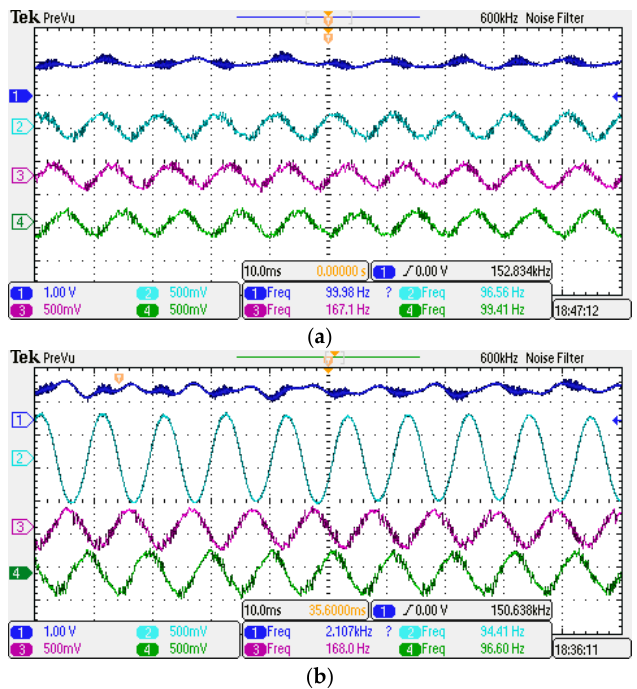
Figure 10. Measured torque (trace 1) and currents (traces 2–4). (10 ms/div, 2 Nm/div, 5 A/div): ( a ) Normal condition; ( b ) Fault ‐ tolerant condition.